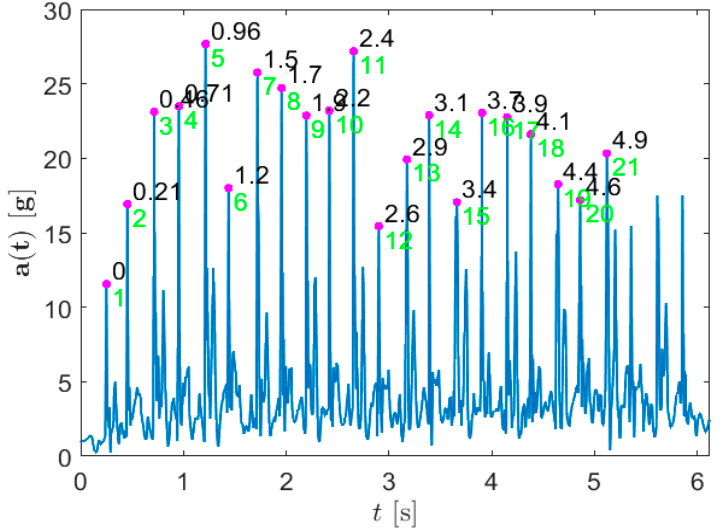
Figure 6. Detecting foot contact point and measuring test’s timing from the IMU acceleration signals. Magenta dots denote the detected points of contact, and in green is the successive contact point enumeration, above which the contact timings with respect to the first contact (in seconds) are also indicated.